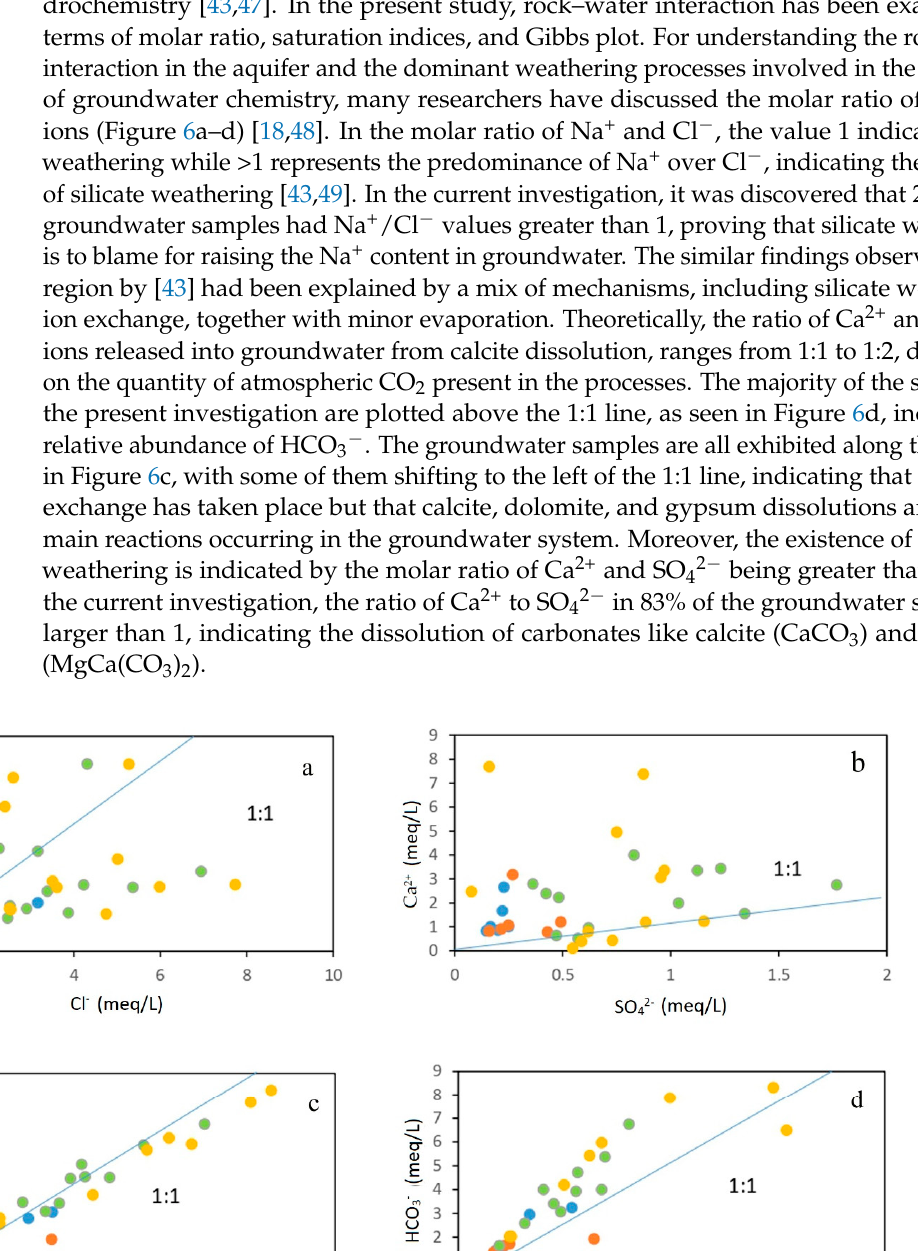
− ) vs. (Ca 2+ + Mg 2+ ), ( d ) Ca 2+ 2 − , ( c ) (SO 2 − + HCO 4 4 3